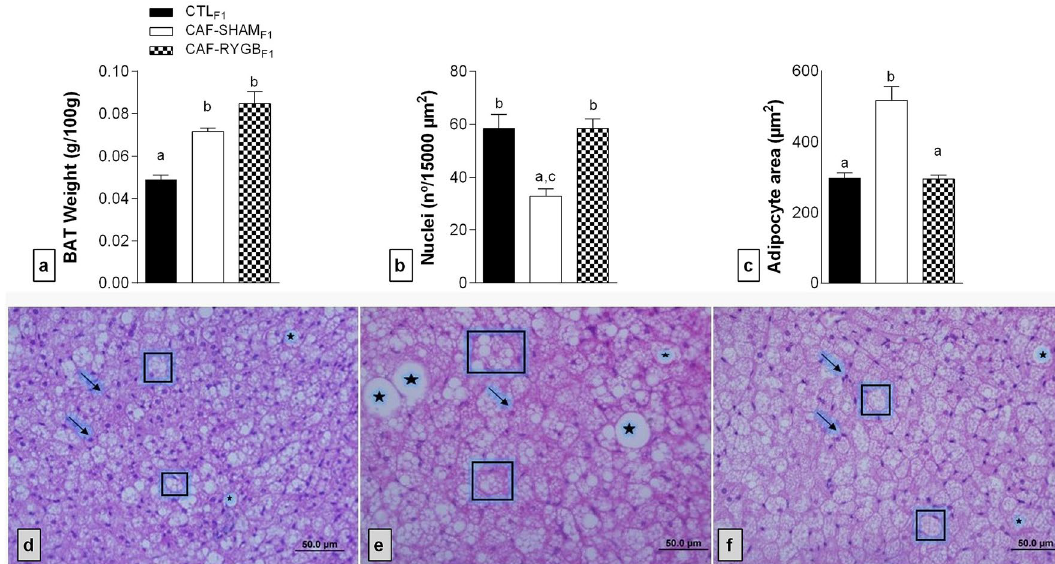
Figure 3. Effect of maternal obesity and RYGB on BAT weight and the nucleus number and adipocyte size in the BAT of male adult offspring rats. CTL F1 , offspring of rats fed standard diet; CAF-SHAM F1 , offspring of rats fed on CAF diet and submitted to sham operation; CAF-RYGB F1 , offspring of rats fed on CAF diet and submitted to RYGB (n = 6 animals/group). Weight of BAT ( a ), nucleus number ( b ) and adipocyte size ( c ) were analysed by light microscopy. Different letters indicate statistical differences by one-way ANOVA and Bonferroni post-test ( p < 0.05). Representative photomicrograph (insert) of BAT (40x), stained with H&E are showed in the figures ( d ) (CTL F1 ), ( e ) (CAF-SHAM F1 ) and ( f ) (CAF-RYGB F1 ). Arrows indicate nuclei and boxes indicate adipocyte area. The data are mean ±